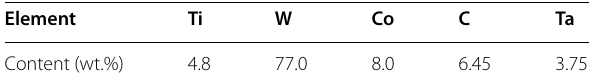
Table 2 Chemical compositions of the milling tool material Element Ti W Co C Ta Content (wt.%)